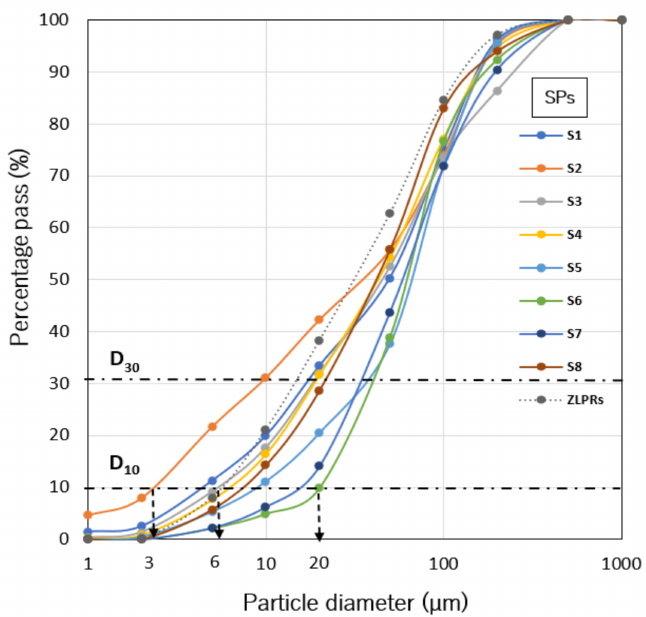
Figure 2. Particle size distribution of SPs and the zinc leach plant residues (ZLPRs) with their 10% and 30% diameters D 10 and D 30